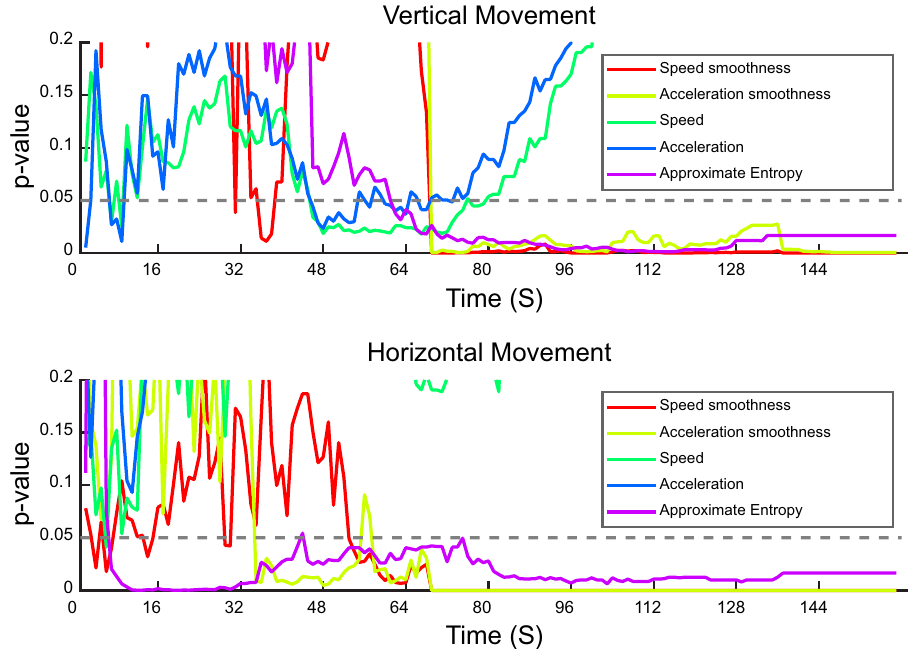
Figure 4. First trial early predictors and task difficulty dependent features. Vertical and horizontal movement features examined over time of rotarod performance. Each parameter was examined for correlation with final rotarod scores for each increasing time segment from the start of the trial. The p value for this correlation analysis for each time segment is depicted on the